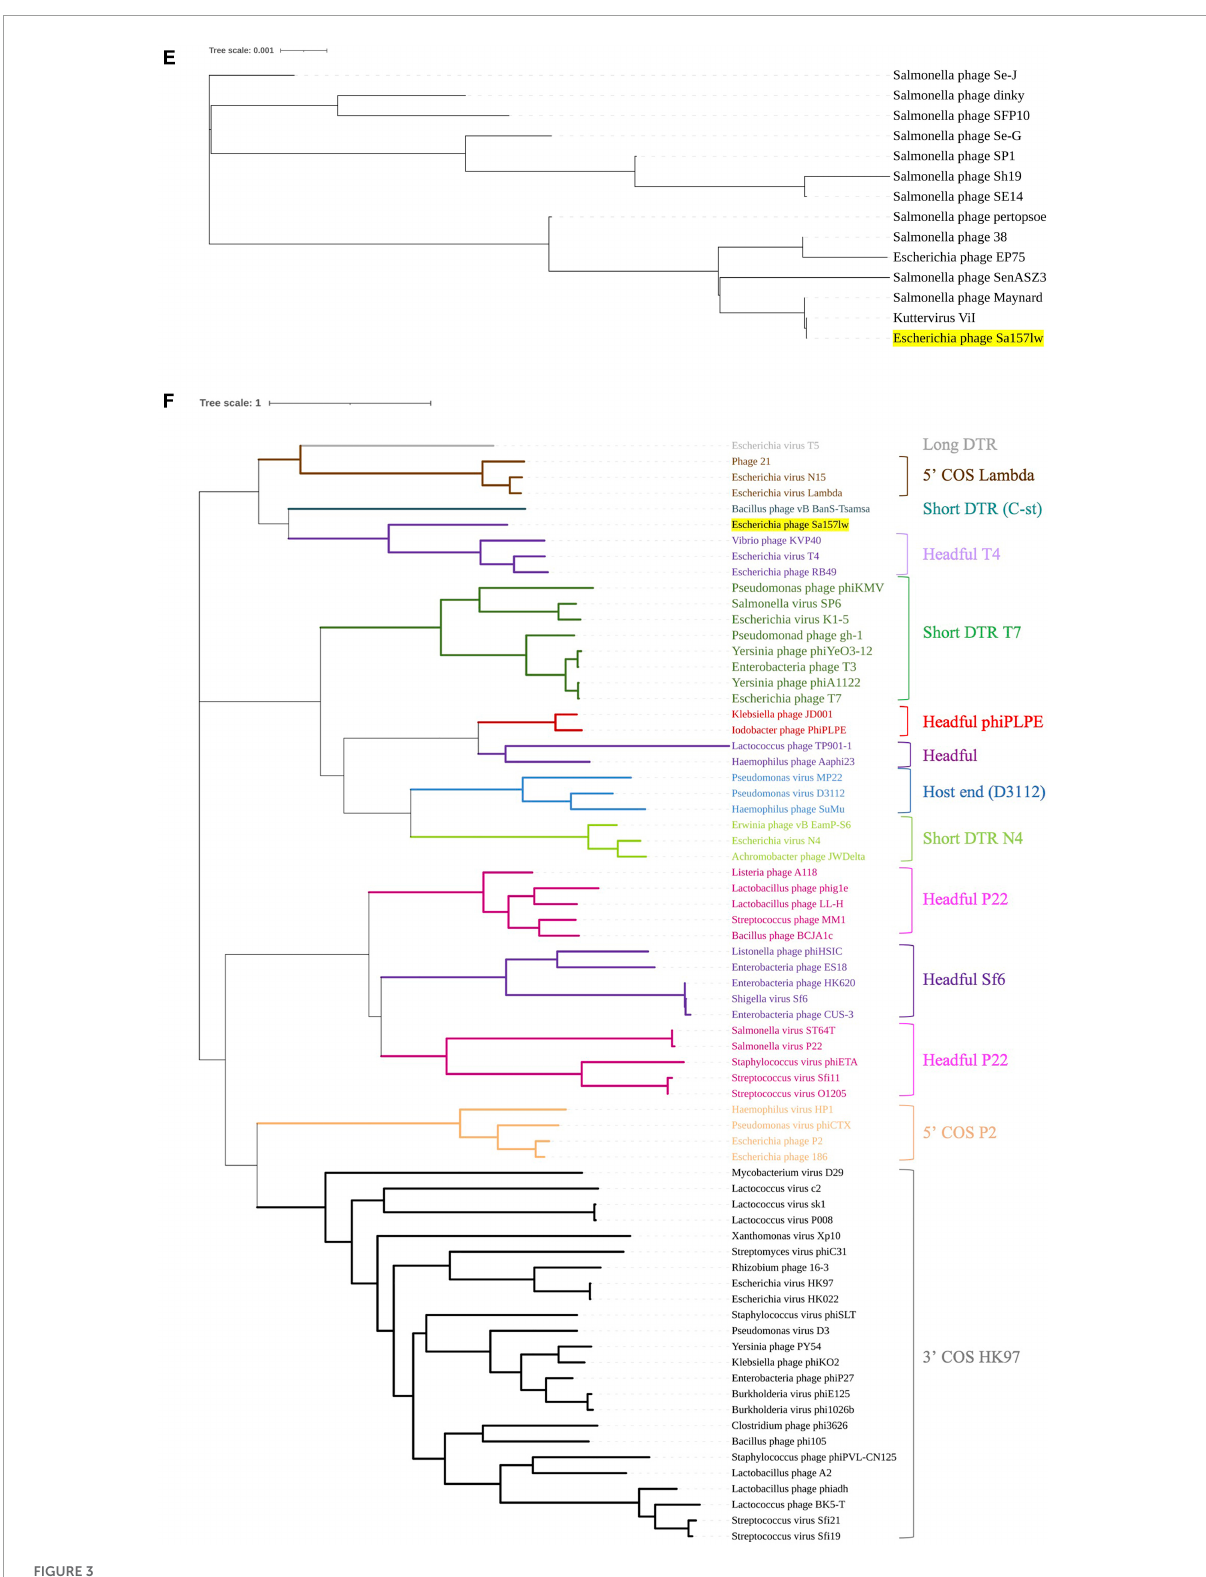
FIGURE3 Neighbor-joining phylogenetic tree of phage Sa157lw (with yellow highlight) and the reference phages belonging to the Kuttervirus genus based on the Clustal Omega alignment of the amino acid sequences of hemolysin-type calcium-binding protein (ORF_101) (A) , tail spike protein (ORF_102) (B) , tail spike protein (ORF_104) (C) , putative tail fiber protein (ORF_103 (D) , tail lysozyme (ORF_196) (E) , and terminase large subunit (F) . The scale represents the homology